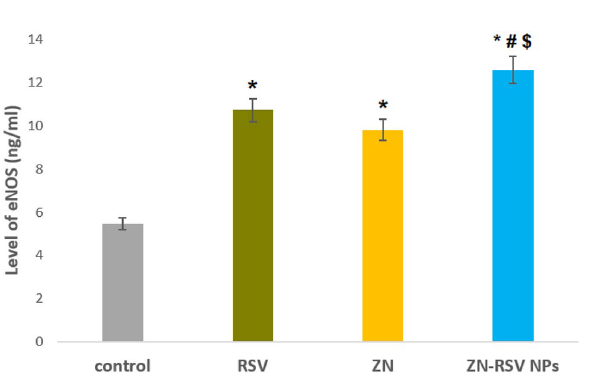
Figure 9. ROS activity in control, RSV and ZN-RSV NPs samples. *Significantly different in comparison with control group at p < 0.05. # Significantly different in comparison with RSV group at p < 0.05. $ Significantly different in comparison with ZN group at p < 0.05.